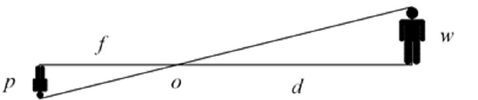
Figure 10. Principle of similar triangle distance measurement.